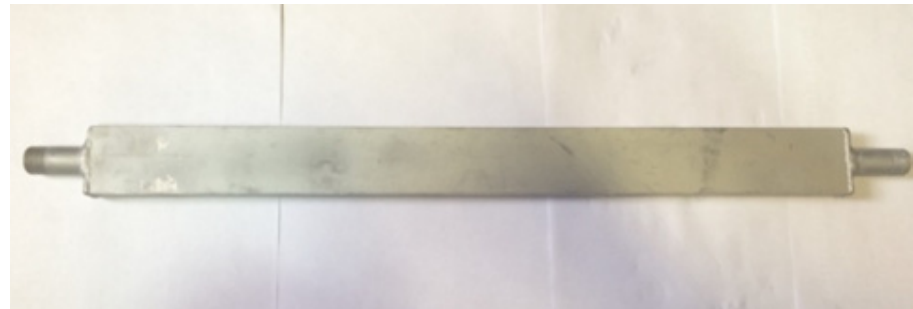
Figure 11. Radiator of the thermoelectric converter unit used in the anode gas cooling module.